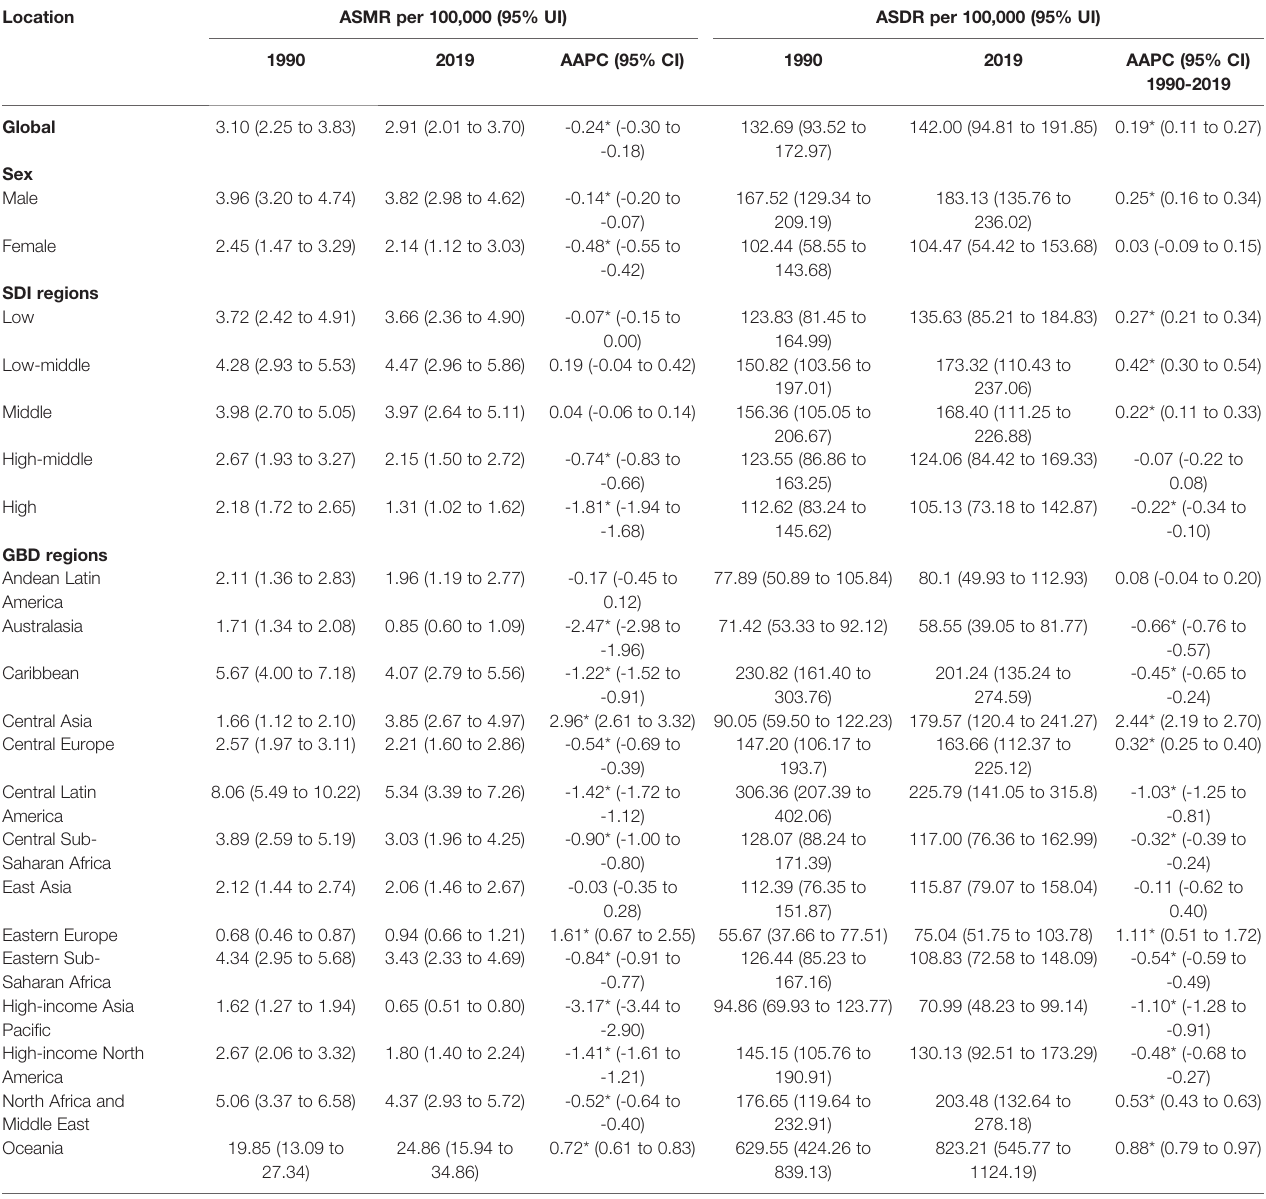
TABLE 1 | ASMR, ASDR, and AAPC in type 2 diabetes attributed to tobacco from 1990 to 2019 by regions.